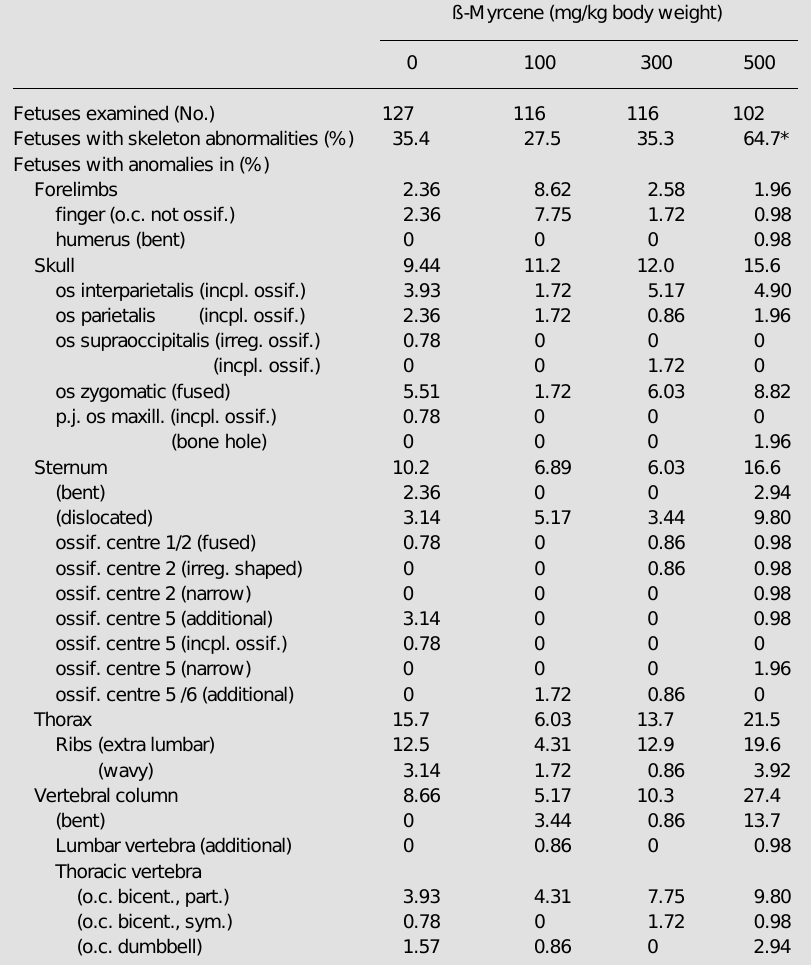
Table 4 - Occurrence of skeletal abnormalities in fetuses from dams treated orally with ß- myrcene (0, 100, 300 and 500 mg/kg) during the premating, mating and pregnancy periods. *P<0.05 compared to controls (chi-square test). Abbreviations: o.c. not ossified = ossification centre not ossified; incpl. ossif. = incomplete ossification; irreg. ossif. = irregular ossification; dumbbell = dumbbell shaped; bicent. = bicentric; part. = partial; sym. = symmetrical. ß-Myrcene (mg/kg body